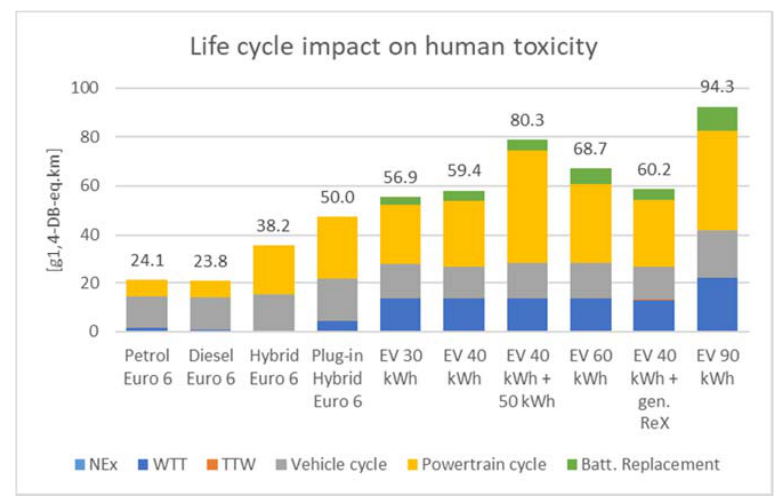
Figure 9. An overview of the well-to-wheel impact on human toxicity per powertrain.